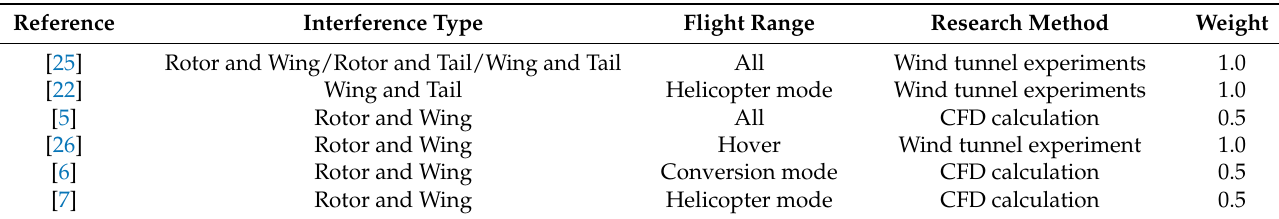
Table 1. Aerodynamic interference calculation references.